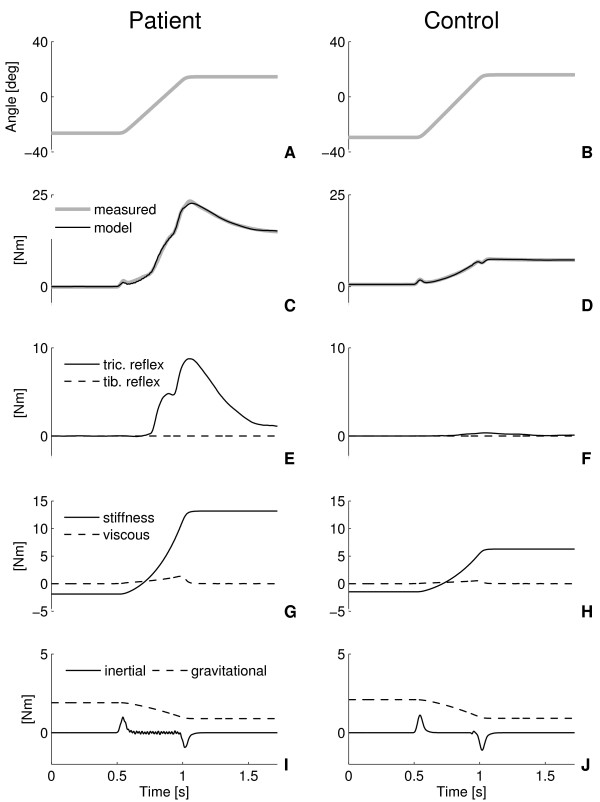
Model fit. Typical model fits at 0.5 s dorsiflexion duration. Left column: patient (AS3). Right column: control subject. A-B: imposed ankle movement; C-D: measured joint torque (grey) and torque as predicted from the model (black); E-F: reflex torque from triceps surae and tibialis anterior muscles; G-H; torque due to stiffness (solid) and viscosity (dashed); I-J: inertial (solid) and gravitational torque (dashed).